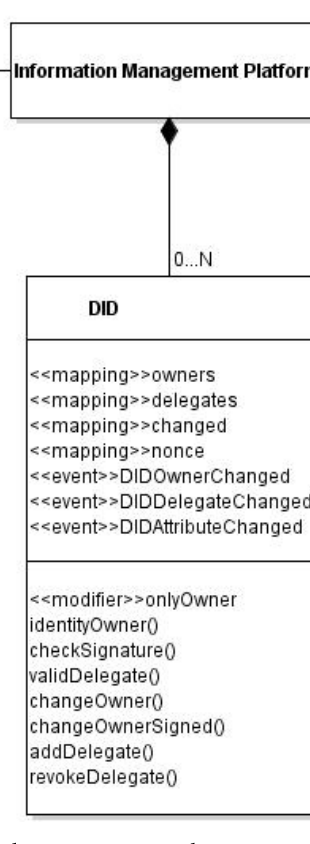
Figure 7. Class diagram of the whole system